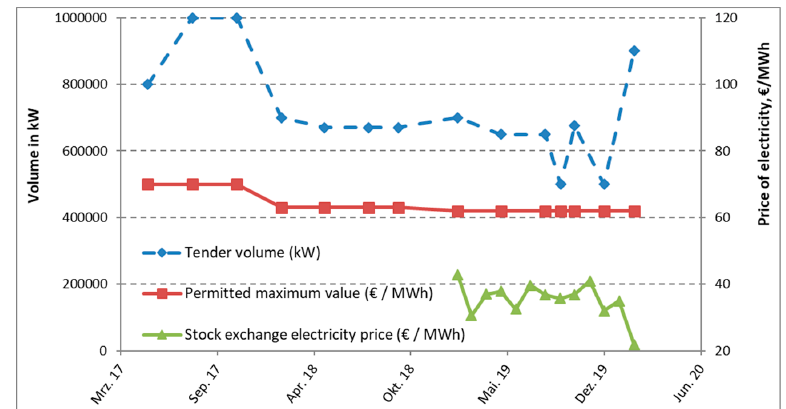
Figure 7. Tender volume (in kW, left Y-axis ) and permissible maximum values for remuneration (in €/MWh, right y-axis ) in Germany at the auction dates, according to the EEG 2017; as well as exchange price on the European Power Exchange (EPEX) spot market for Germany/Luxembourg from February 2019 to February 2020 [20; 21], own illustration.